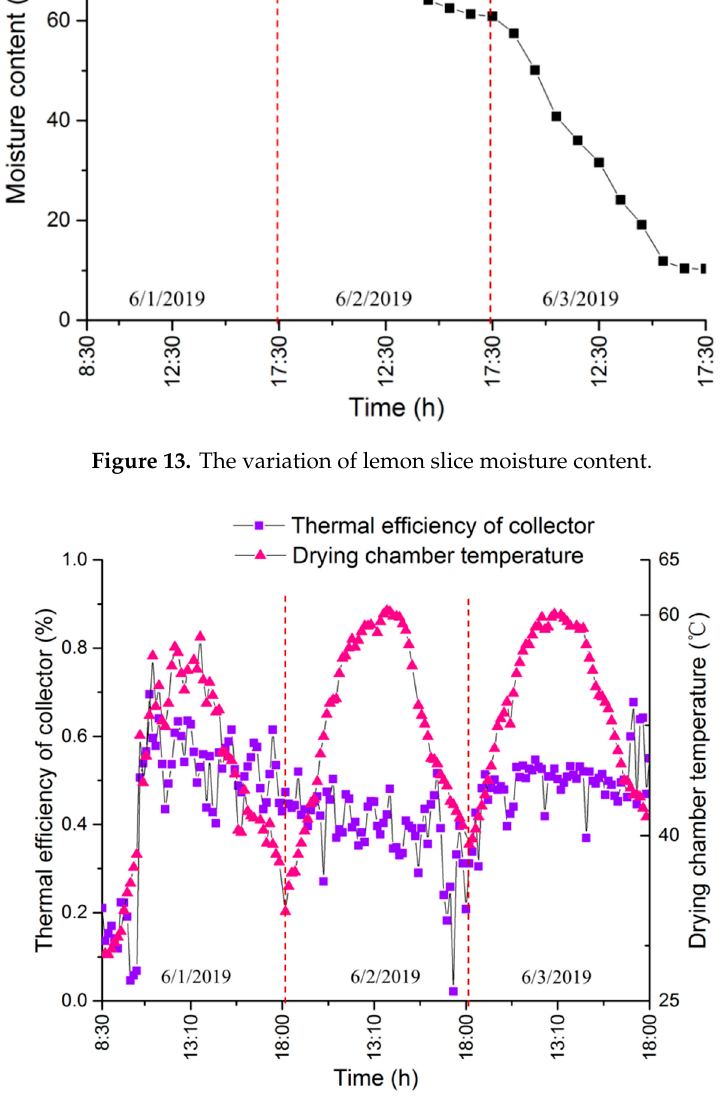
Figure 13. The variation of lemon slice moisture content.